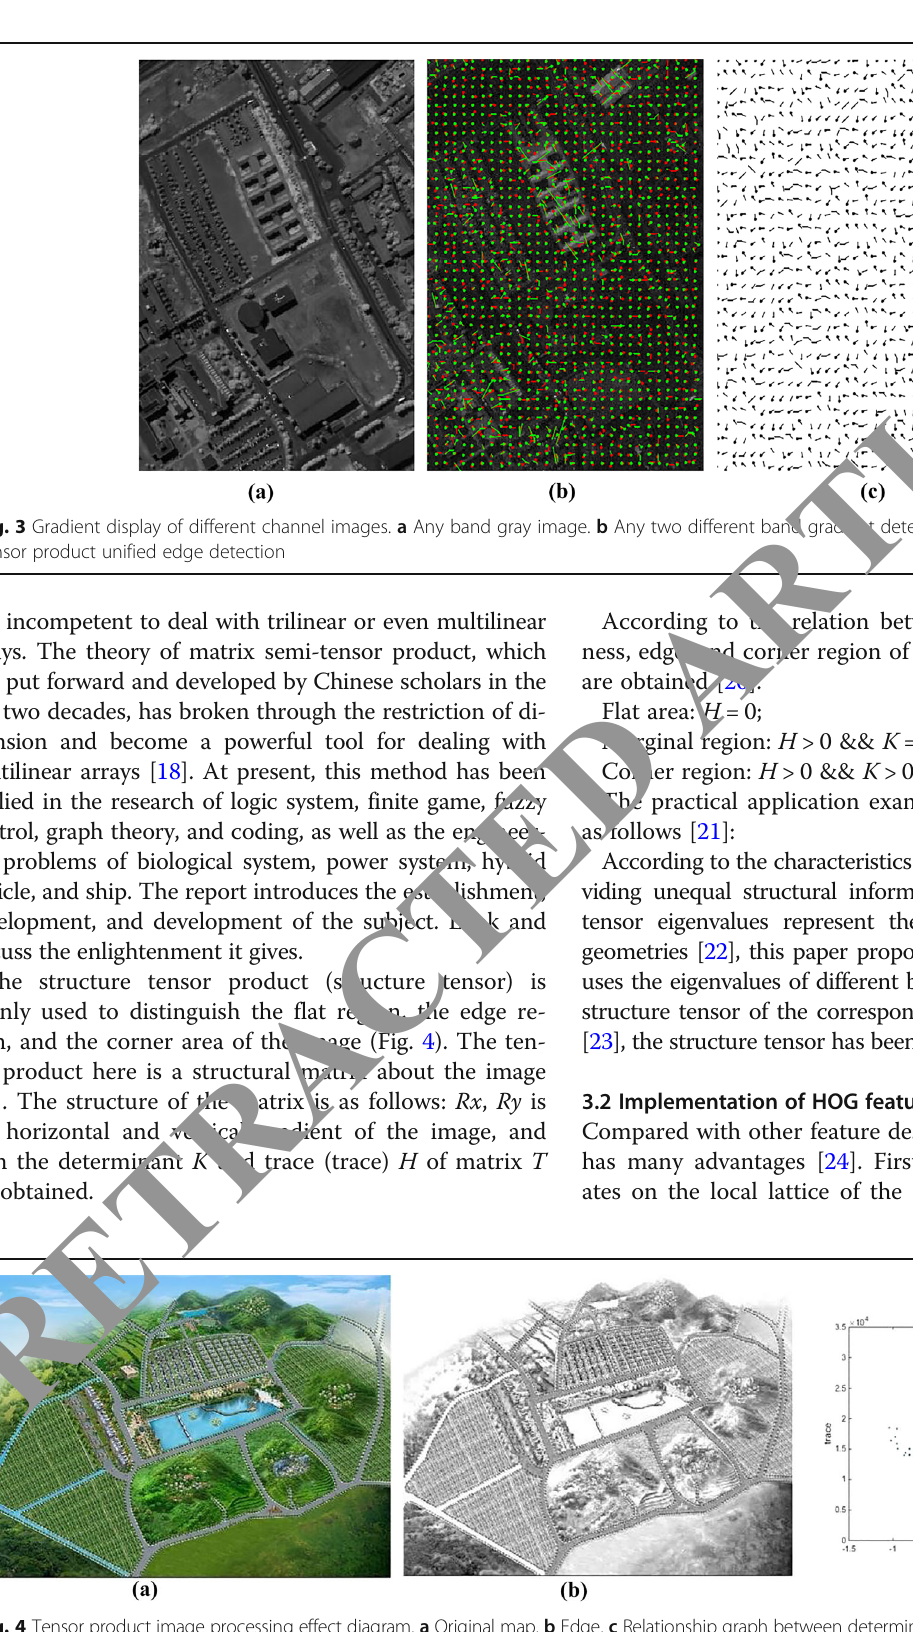
Fig. 4 Tensor product image processing effect diagram. a Original map. b Edge. c Relationship graph between determinant and trace in edge